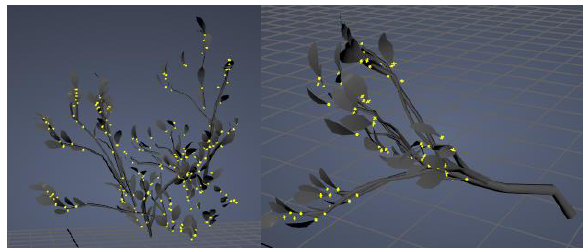
Figure 8. 3D tree elements generated from Clara.io